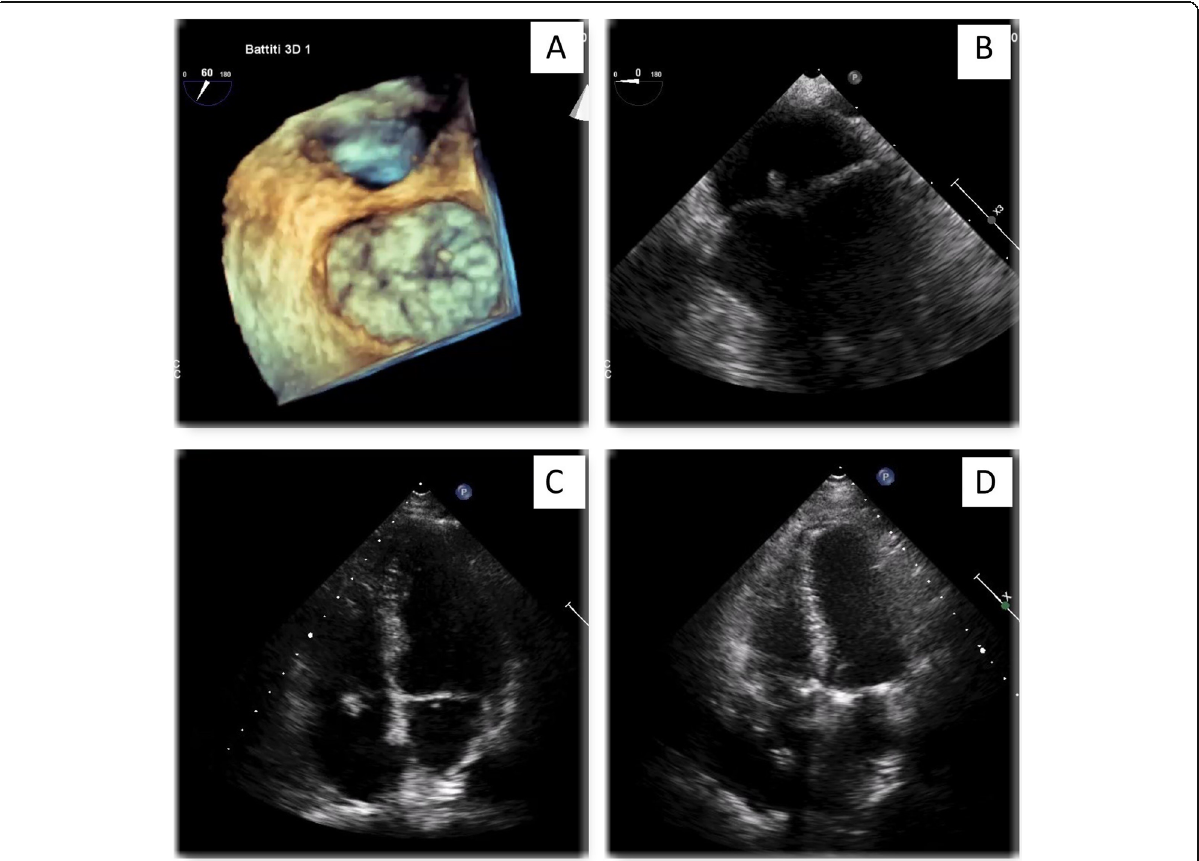
Fig. 2 Echocardiographic images of the patient with mitral and tricuspid IE. a 3D transesophageal view of mitral valve. b 2D transesophageal view of mitral valve. c Transthoracic four chamber view before surgery. d Transthoracic four chamber view after surgery. Vegetation is marked with arrows in each view